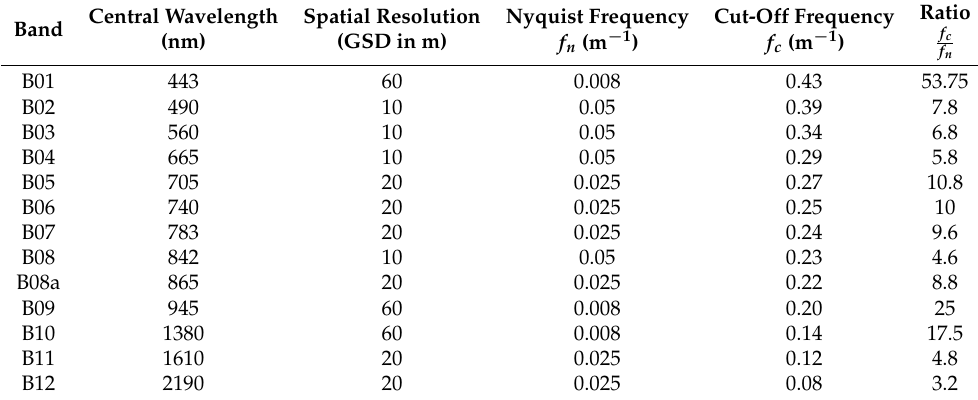
Table 1. Table of the cut-off frequencies and Nyquist frequencies for each band of